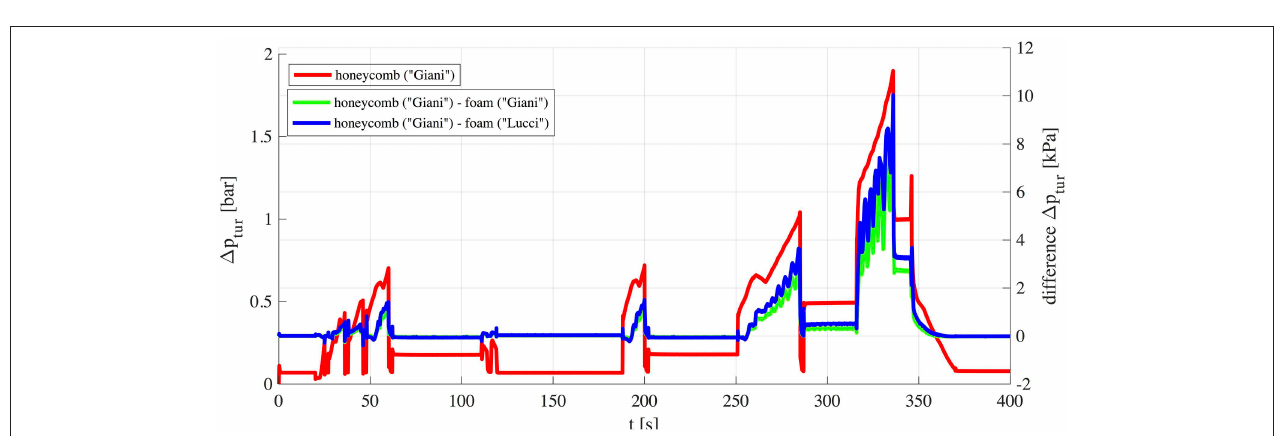
FIGURE 8 | Calculated pressure changes through